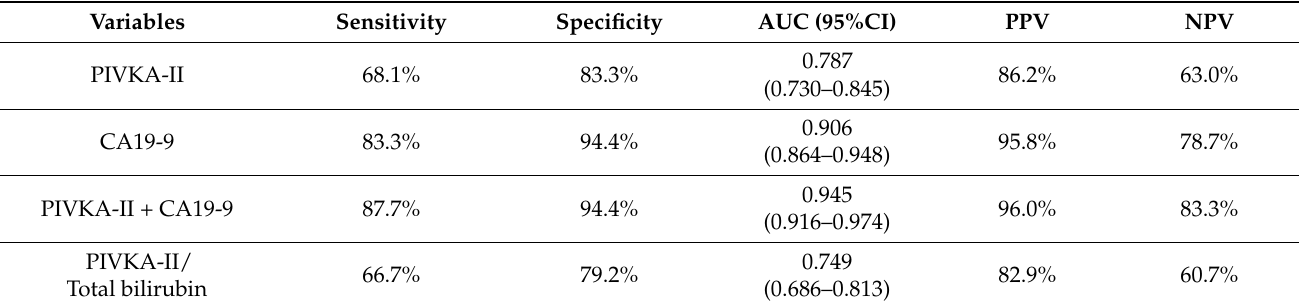
Table 3. Sensitivity, specificity, PPV, and NPV of different biomarkers in discriminating PDAC from pancreatic benign lesions.